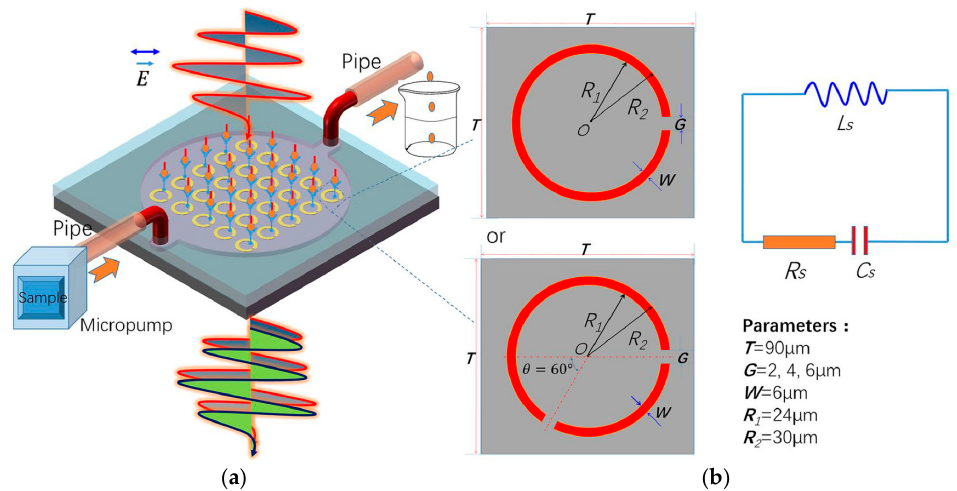
Figure 14. ( a ) THz metamaterials microfluidics biosensor; and ( b ) equivalent circuit with {RLC}s for the SRRs (redrawn from [86]).